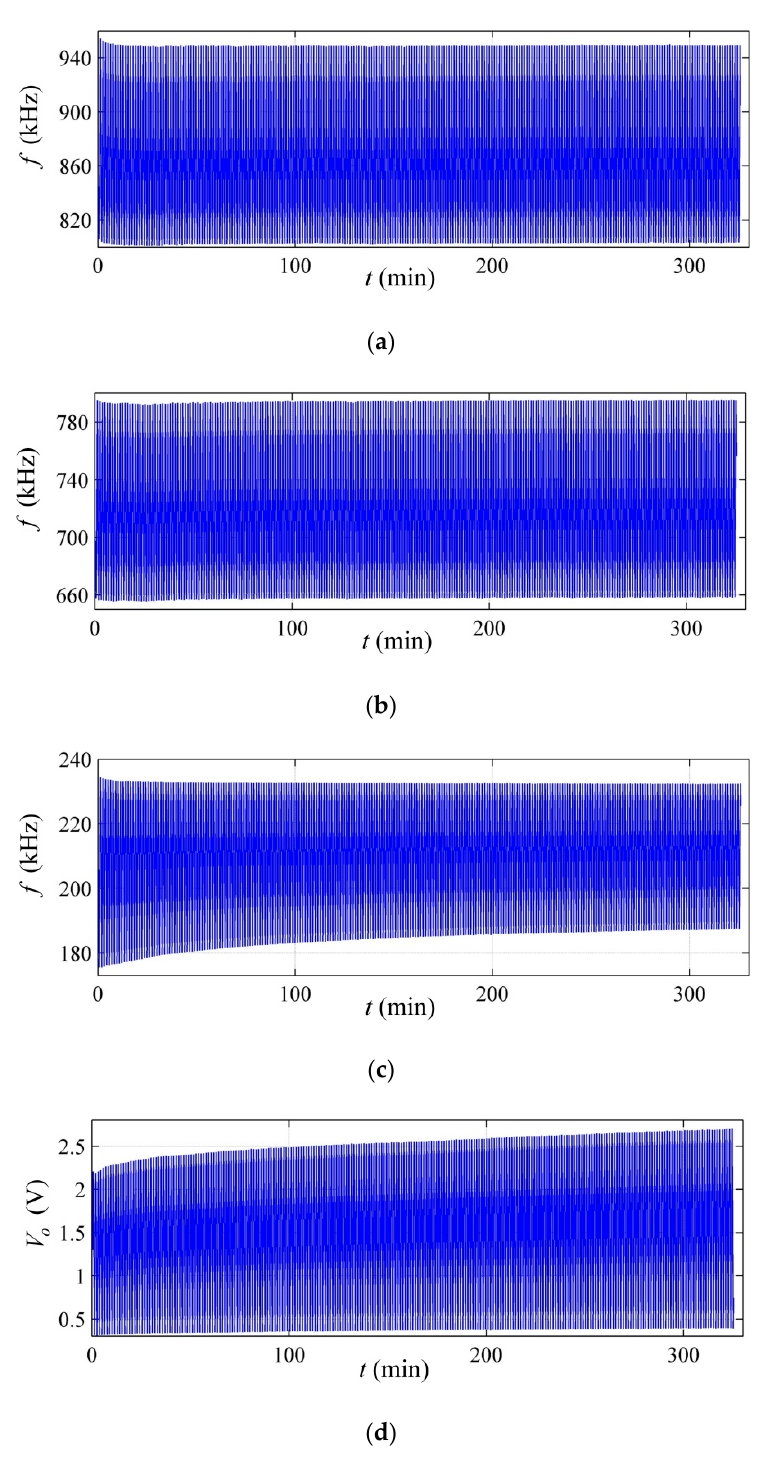
Figure 10. The experimental results of sensor testing using the stress signal of Equation (20) and different experimental setups. The authors’ proposed circuit in Figure 3 at ( a ) R 1 = R 2 = 510 Ω with Vcc = 2.5 V; ( b ) R 1 = 510 Ω , R 2 = 1.2 k Ω with Vcc = 2.5 V; ( c ) R 1 = R 2 = 5 k Ω with Vcc = 10 V; ( d ) The Vcc = 2.5 V; ( b ) R 1 = 510 Ω , R 2 = 1.2 k Ω with Vcc = 2.5 V; ( c ) R 1 = R 2 = 5 k Ω with Vcc = 10 V; ( d )